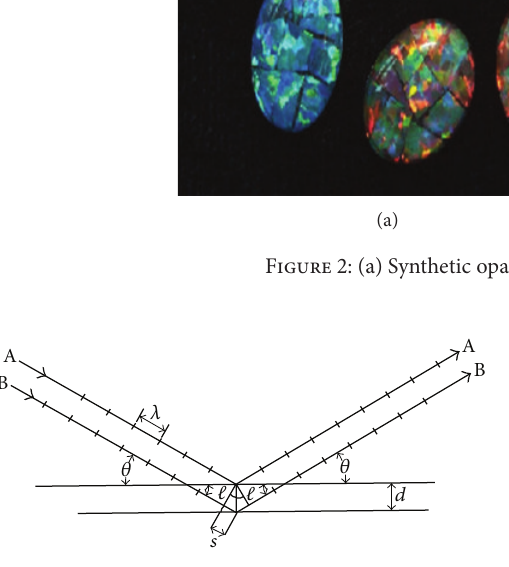
Figure 3: The diffraction of the light by crystal planes [30].